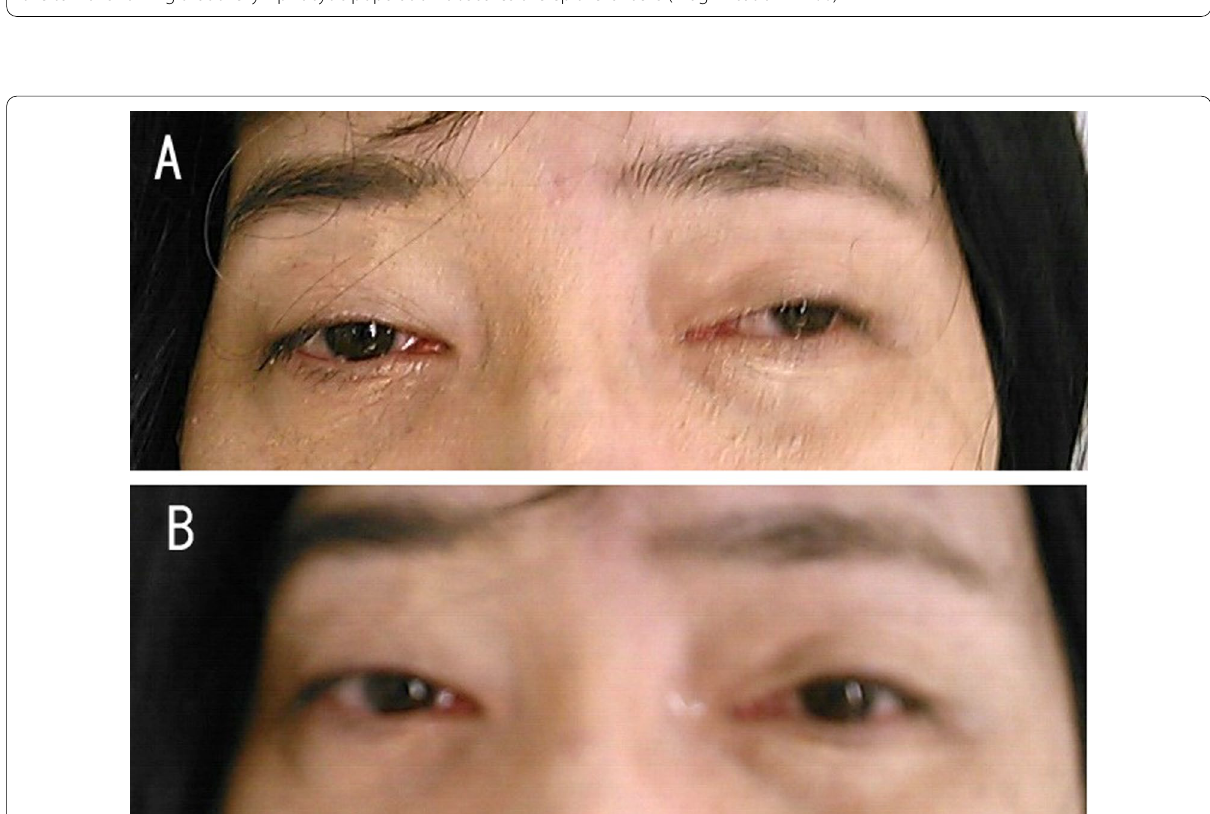
Fig. 2 Patient has mild bilateral ptosis ( a ). The ptosis improved after the administration of edrophonium ( b